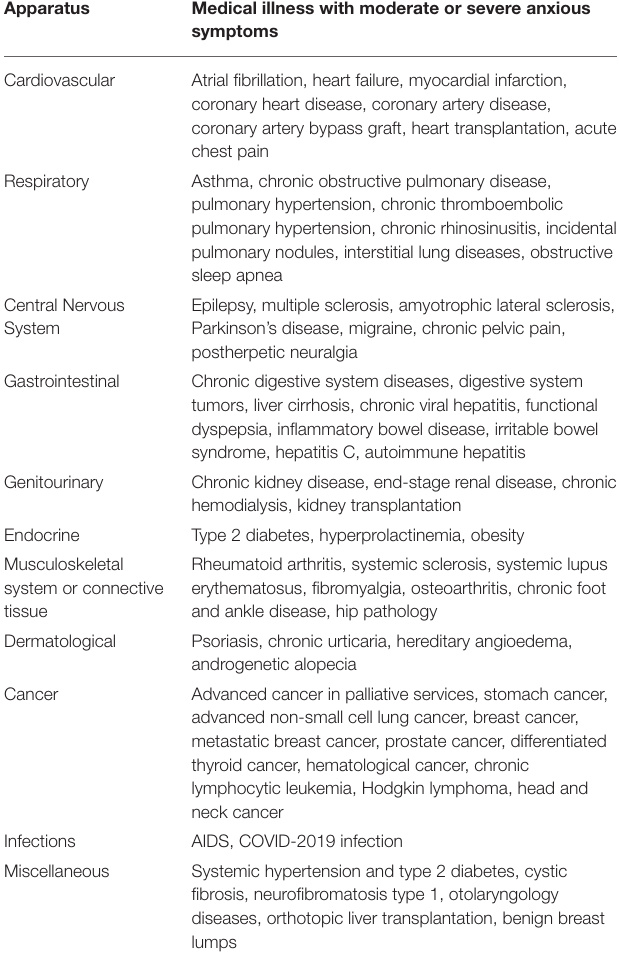
TABLE 1 | Moderate or severe anxiety symptoms in medical